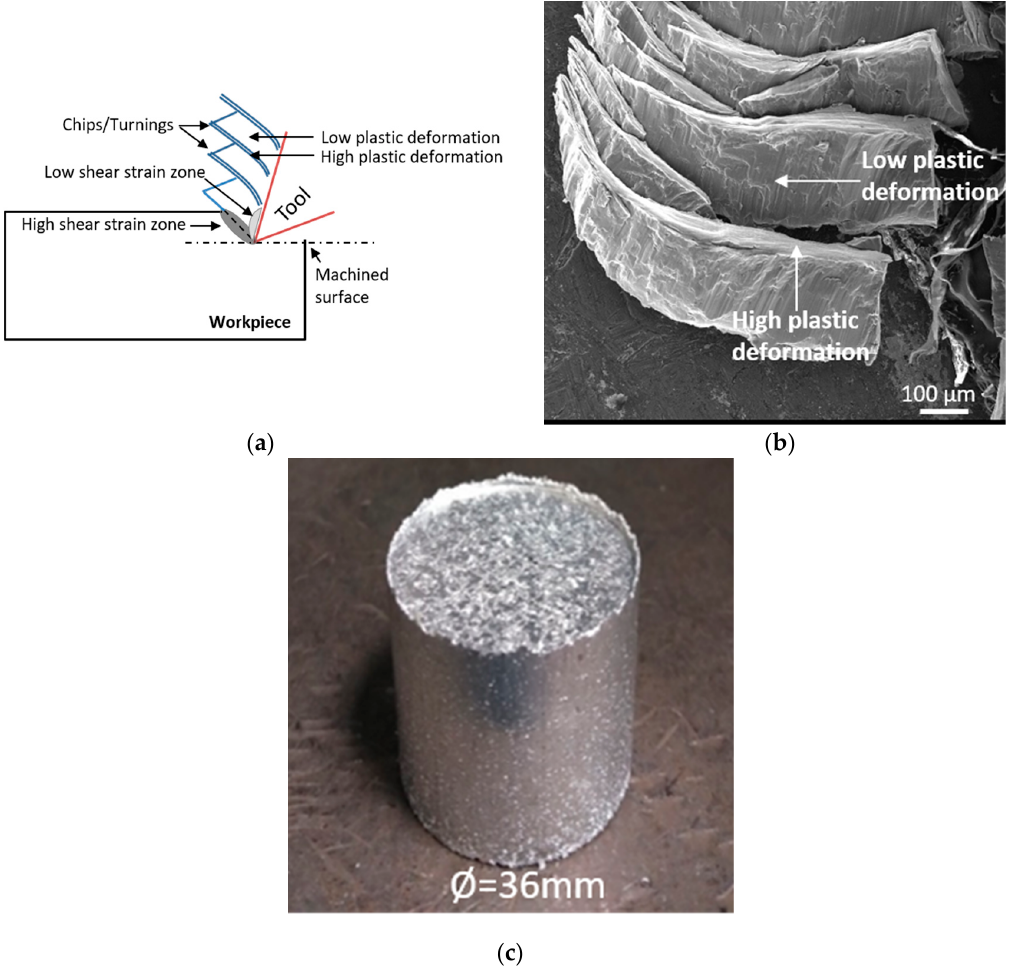
Figure 2. ( a ) Chip formation during turning; ( b ) chips/turnings (Depth of cut DOC of 1.5 mm) with apparent plastic deformation zones; ( c ) turnings compacted into a billet.